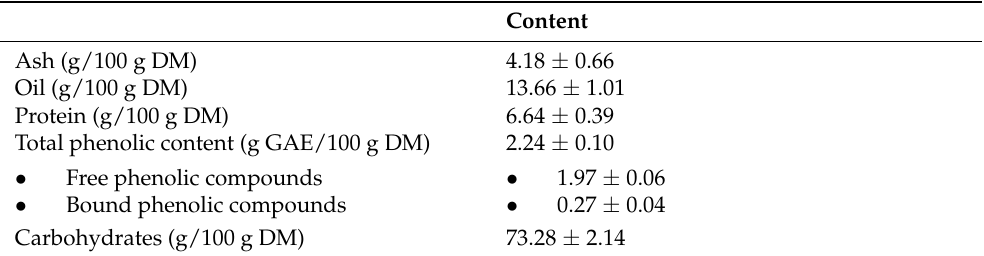
Table 2. OP proximate